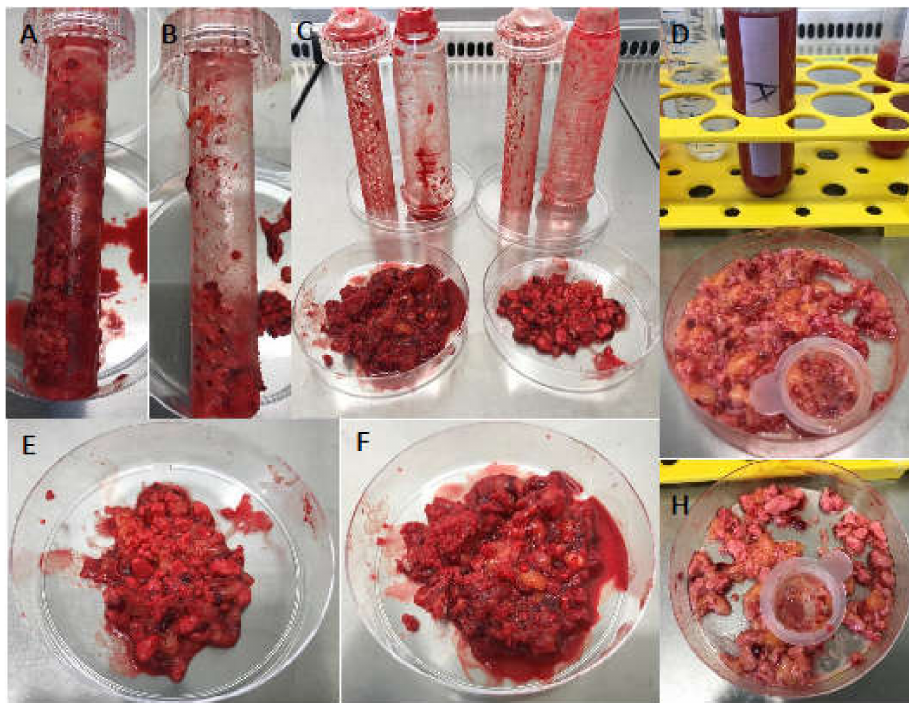
Figure 5. Content of the surgical vacuum suction handle after application in arthroplasty surgeries. Surgical vacuum suction device’s inner part filled with allogenic (Allo) or synthetic (TCP) bone substitute material (BSM) ( A , F ) ( B , E ). The polystyrene container was opened under the laminar flow bench. The BSM and retained cell-tissue composite (CTC) were placed in petri dishes ( C ) and washed with phosphate-bu ff ered saline (PBS) and filtered. ( D ) Residual allogenic BSM ( D ), residual TCP ( H